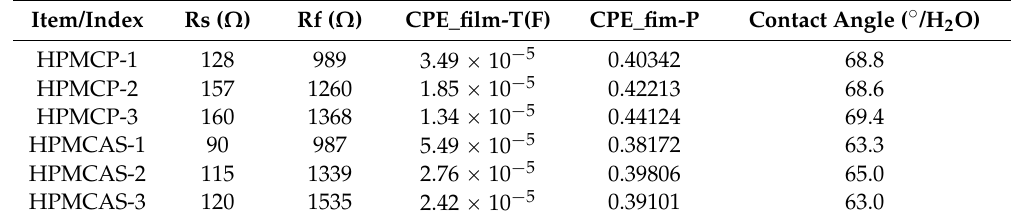
Table 4. Electrochemical corrosion measurement of HSS, HPMCP and HPMCAS coated